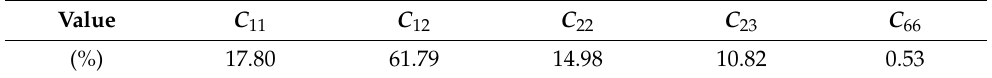
Table 6. Deviation percentage of the measured stiffness matrix with the image resolution 501 × 501.